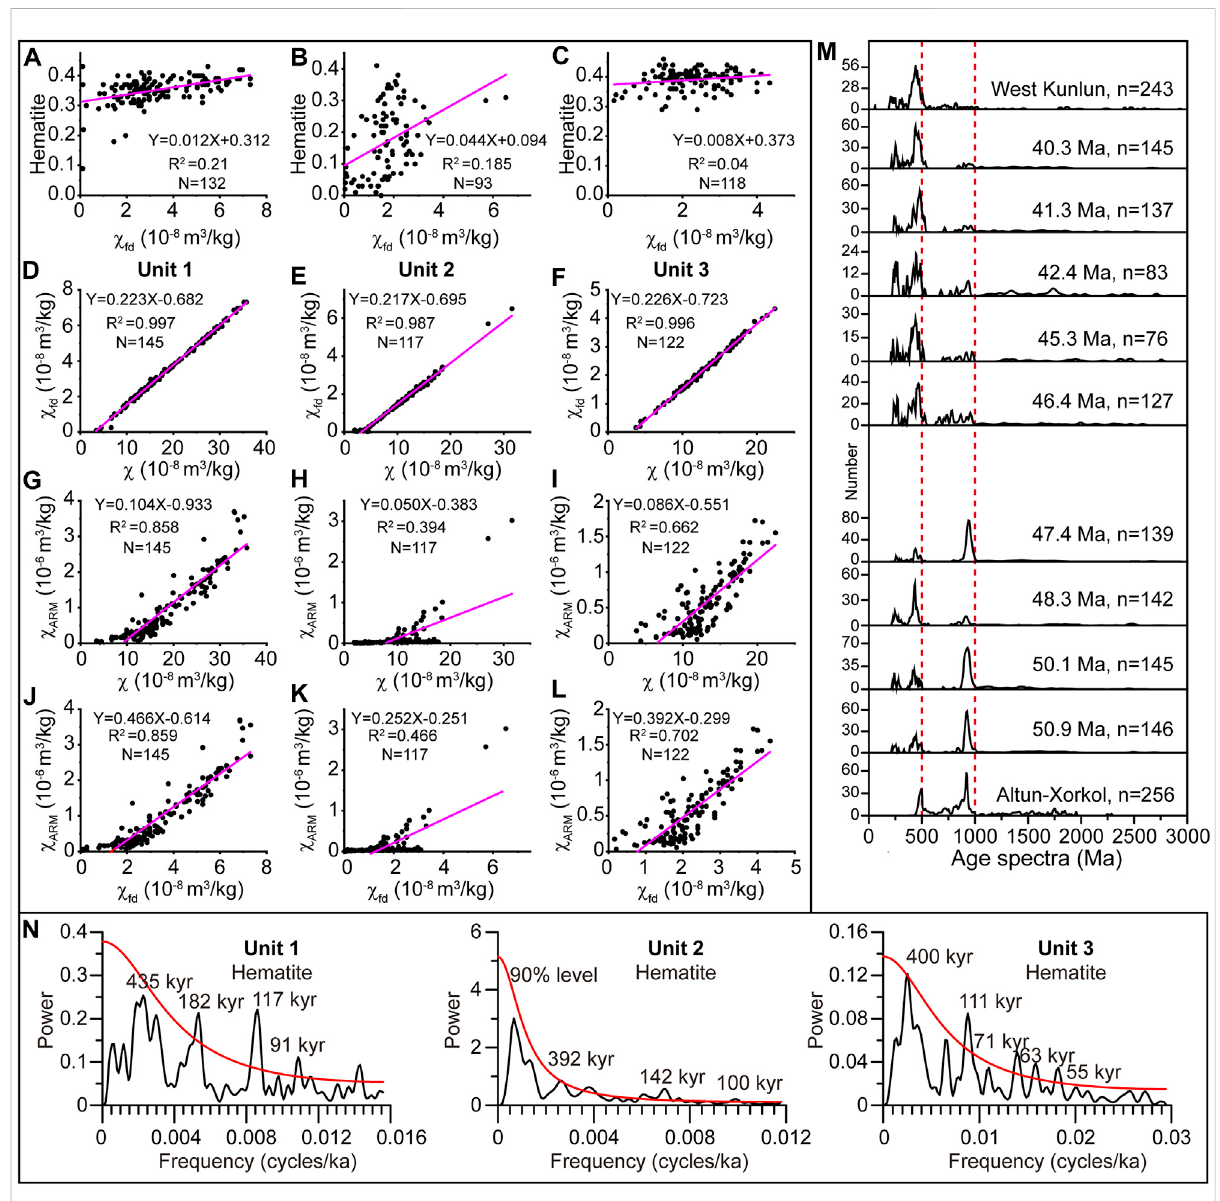
FIGURE 3 (A – L) Correlation analysis of magnetic parameters of the Xishuigou eolian Red Clay section. Relationship for hematite versus χ fd , χ fd versus χ , versus χ ,and χ versus χ χ ARM ARM fd .(A,D,G,and (J) ,(B,E,H,and (K) ,(C,F,I,andL)arefromUnits1,2,and3,respectively. (M) Comparationofthedetrital zircons U-Pb ages results of the Xishuigou eolian Red Clay section with possible source areas (Pan et al., 2022). (N) Power spectral results of the hematite content from Units 1, 2, and 3,